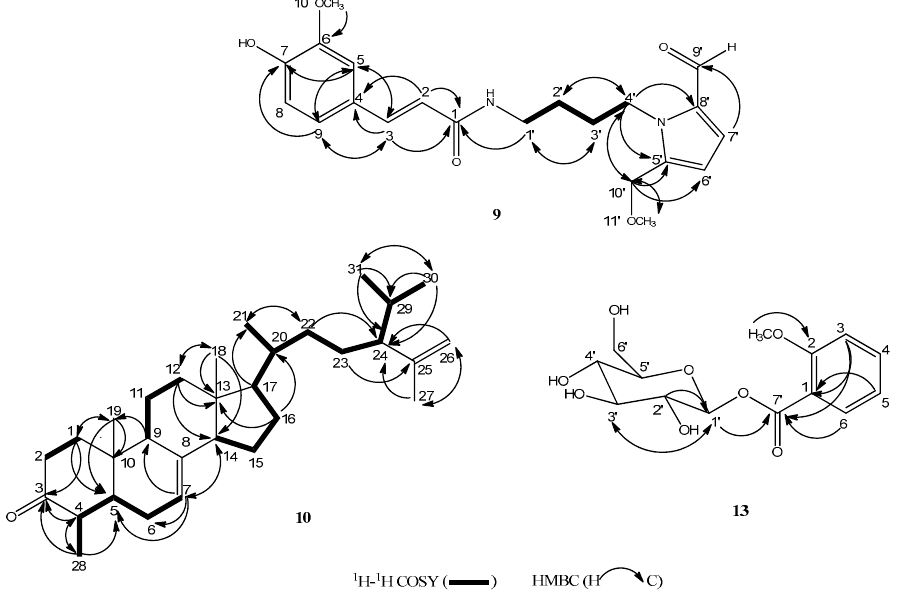
Figure 2. The key COSY and HMBC correlation signals of the new compounds.